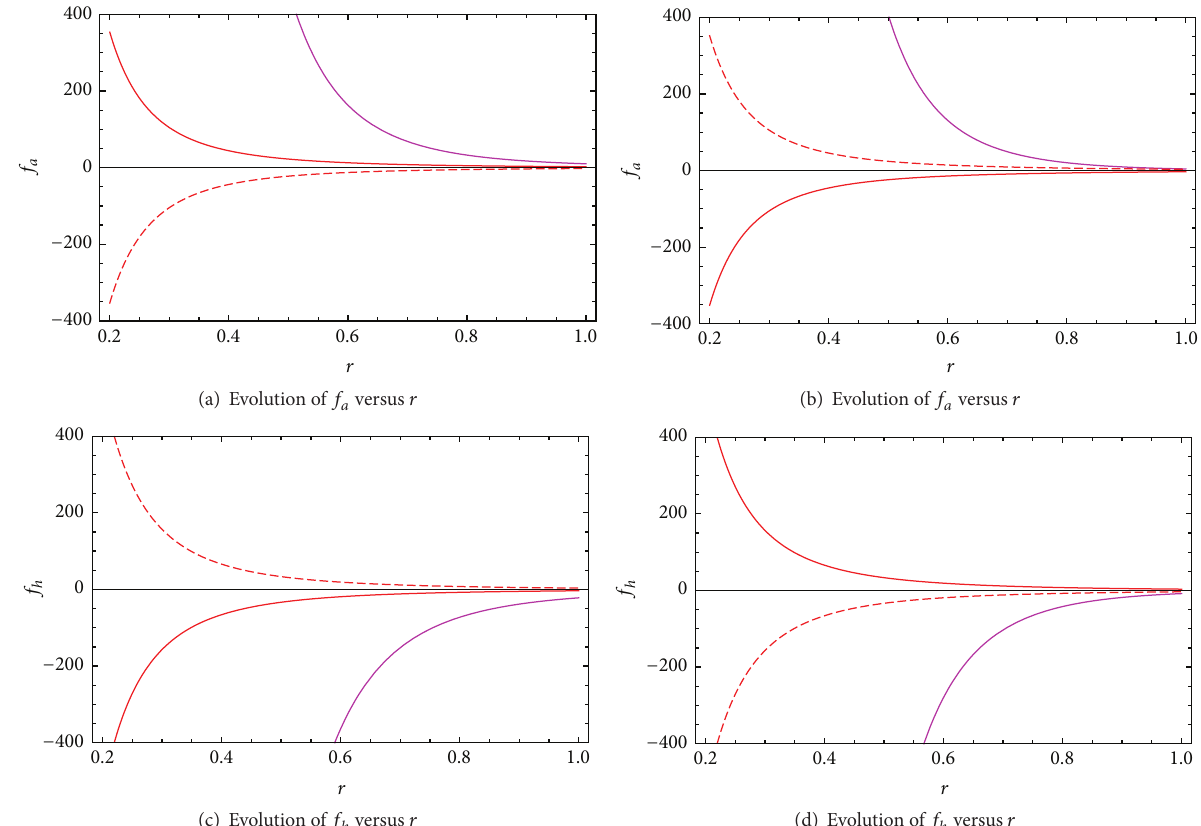
Figure 10: Plots of (a) 𝑓 𝑎 for 𝑠 + , (b) 𝑓 𝑎 for 𝑠 − , (c) 𝑓 ℎ for 𝑠 + , (d) 𝑓 ℎ for 𝑠 − versus 𝑟 with Lorentzian distribution for 𝑛 = 5 , 𝜖 = 1 (red), 𝑛 = 5 , 𝜖 = −1 (red dashed), and 𝑛 = 6 , 𝜖 = 3 (purple).